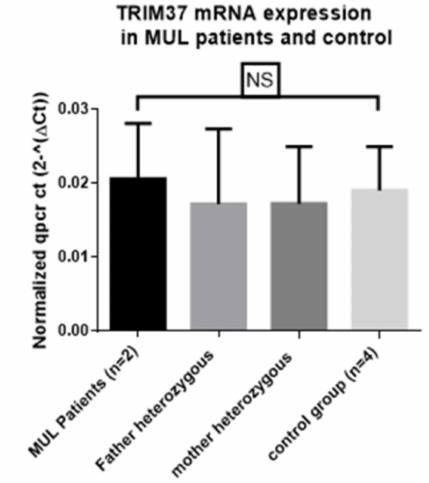
Figure 4. mRNA TRIM37 expression in MULIBREY patients (MUL), heterozygous parents, and control. NS: not significant. Total RNA was extracted in peripheral blood mononuclear cell by RNeasy minikit (QIAGEN). Retrotranscription were realized with cDNA transcription kit (Applied Biosystems) and qPCR was performed with Power SYBR green (Applied Biosystems) in Quanstudio7 (Thermofisher). TRIM37 primers sequence: AACAGAAGCGTGGAGAGCATT (exon1-2) and CTTCTGCCCAACGACAATTT (exon 4) described previously in Reference [14]. Results were normalized by 2 − ∆ Ct method with β -actin as reference gene as described previously [46]. This figure represents three independent experiments (Brigant et al., unpublished